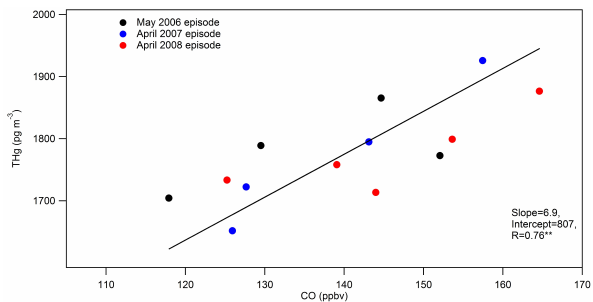
Fig. 4. Elevated CO and THg concentrations and THg/CO enhance- ment ratios measured during May 2006, April 2007, and April 2008 high-RGM events are suggestive of Asian long-range trans- port (ALRT). Due to the small number of data points during each individual event, we calculated the slope by using all data during episodes combined. The THg/CO correlation slope for the com- bined events is similar to Asian emission ratios measured previously (Jaffe et al., 2005; Weiss-Penzias et al.,